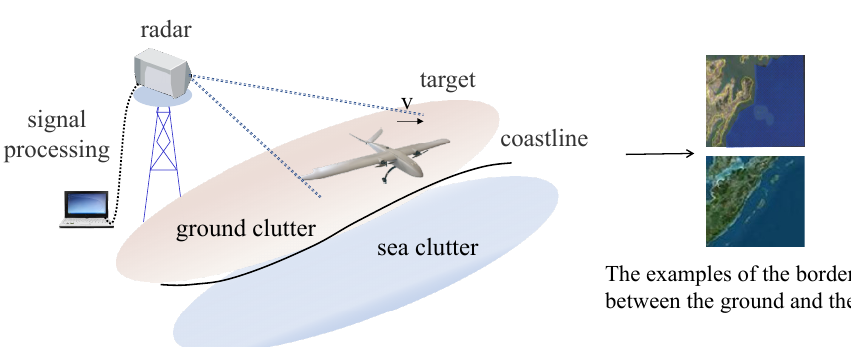
Figure 1. Schematic diagram of the detection scene. It depicts the scene of an aircraft target flying over the land-sea border area. This scene is a typical example of changing scenes, and is the research scene set in the experiment of this